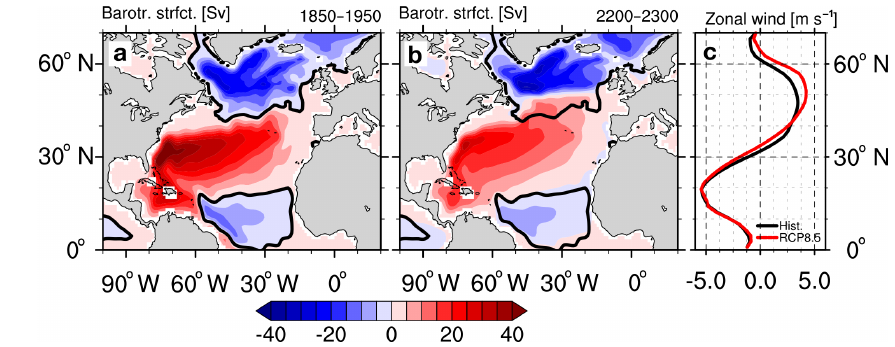
Figure 2. The barotropic stream function (Sv = 10 6 m 3 s − 1 ) in (a) the historical simulation (1850–1950) and (b) RCP 8.5 (2200–2300) for the time mean over the respective periods. The thick black line shows the zero contour in the historical simulation. Contour interval is 5Sv. (c) Zonal mean zonal wind (at 1000hPa) averaged over the North Atlantic region (90 ◦ W to 10 ◦ E) for the historical simulation (black) and RCP 8.5 (red), indicating the northward shift of the westerlies.